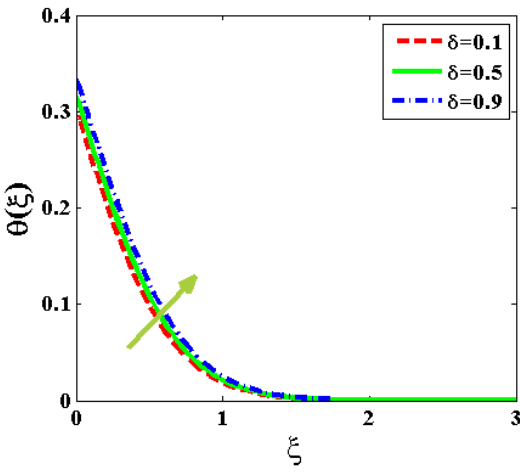
Figure 14. Outlines of 𝜃 at diverse quantities of 𝛿 .